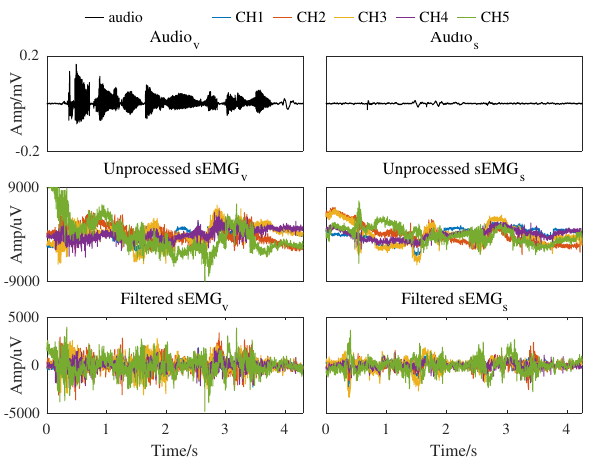
Figure 2. Time–series plots of the audio waveform and neuromuscular signal from Spk-3 with vocal mode and silent mode for the Chinese sentence “tui4 yi4 yun4 dong4 yuan2 you3 shen2 me5”. The audio and neuromuscular signal of the same mode are collected